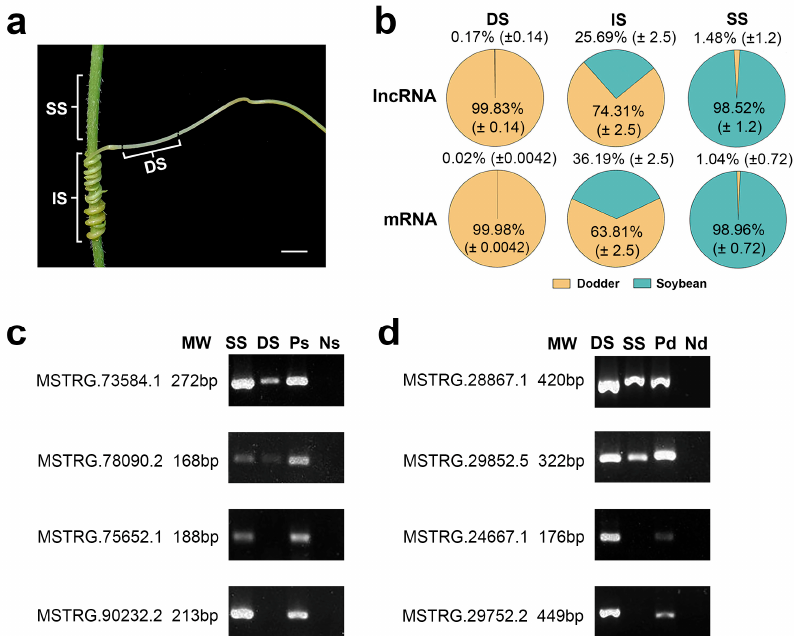
Figure 3. Transcript transfer in soybean–dodder parasitization systems: ( a ) Sequencing and analysis of three types of tissues, including the dodder stems (DS), interface stems (IS), and soybean stems (SS). Scale bars = 5 mm; ( b ) Pie charts illustrating the proportion of reads from foreign and native lncRNAs or mRNAs in each tissue. Calculations were based on the ratio of the reads mapped only to the foreign genome and total reads mapped to the foreign and native genomes. The values are the mean ± standard deviation of three replicates. DS, IS, and SS represent dodder stems, interface stems, and soybean stems, respectively; ( c ) RT-PCR confirmed the transfer of lncRNAs into the dodder for two soybean lncRNAs, MSTRG.73584.1 and MSTRG.78090.2; MSTRG.75652.1 and MSTRG.90232.2 were not detected in the dodder by RNA-seq. SS represents soybean stem; DS represents dodder stem; Ps represents positive control (soybean without dodder); Ns represents negative control (dodder not growing on soybean); ( d ) RT-PCR confirmed the transfer of lncRNAs into the host for two dodder lncRNAs, MSTRG.28867.1 and MSTRG.29852.5; MSTRG.24667.1 and MSTRG.29752.2 were not detected in soybean by RNA-seq. DS represents dodder stem; SS represents soybean stem; Pd represents positive control (dodder not growing on soybean); Nd represents negative control (soybean without